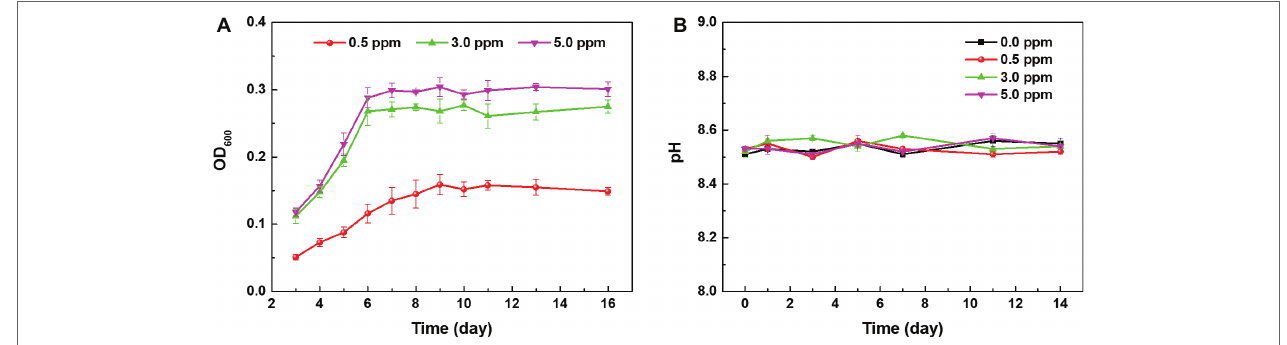
FIGURE 1 | (A) Growth curves of archaeon N. tibetense in inoculated media with different DOCs and (B) the evolution of pH values of different inoculated media with